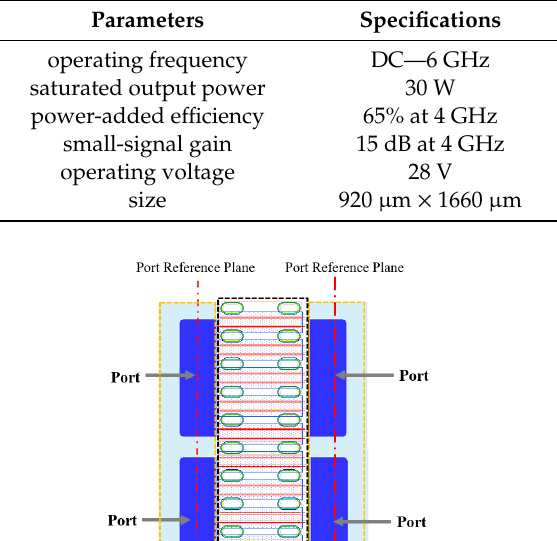
Figure 2. Modified large-signal transistor model with a foundry process design kit model and electromagnetic simulation pad models. Table 1. Device parameters of CGH60030D.